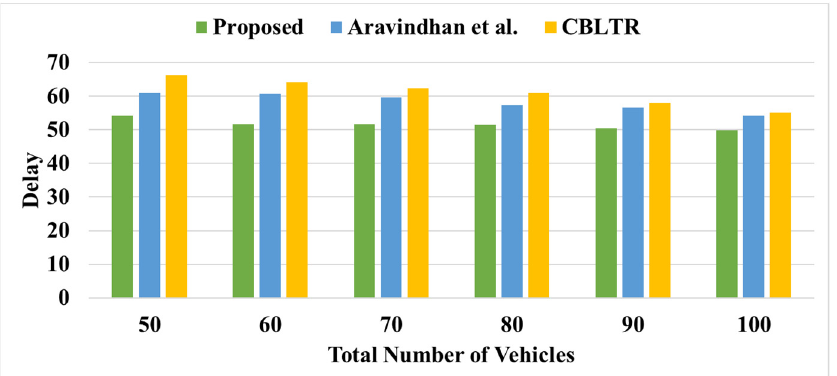
Figure 10. Comparison of results of the proposed system and existing systems (Aravindhan et al. [24] and CBLTR [21]) on delay versus vehicular nodes in area 1500 × 1500.